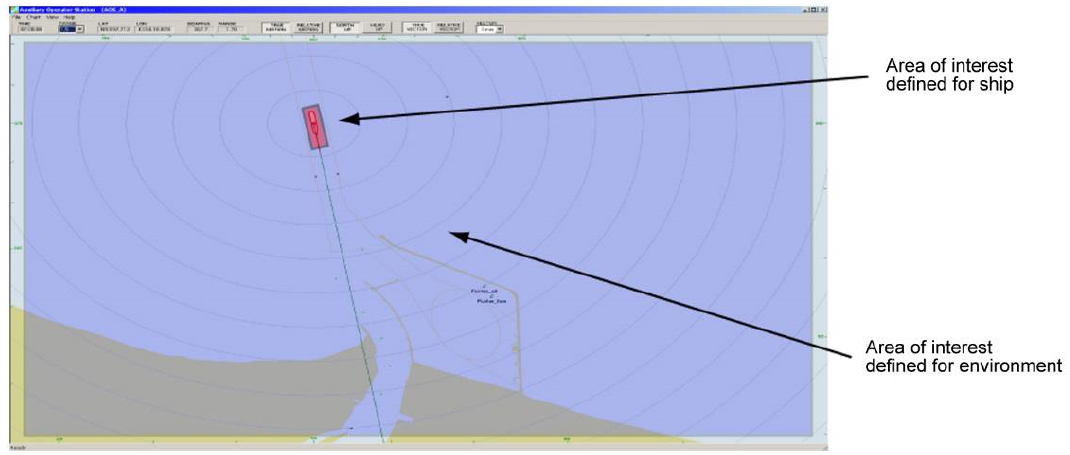
Figure 8. The areas of interest intended for the ship and the environment related to the pilot system.